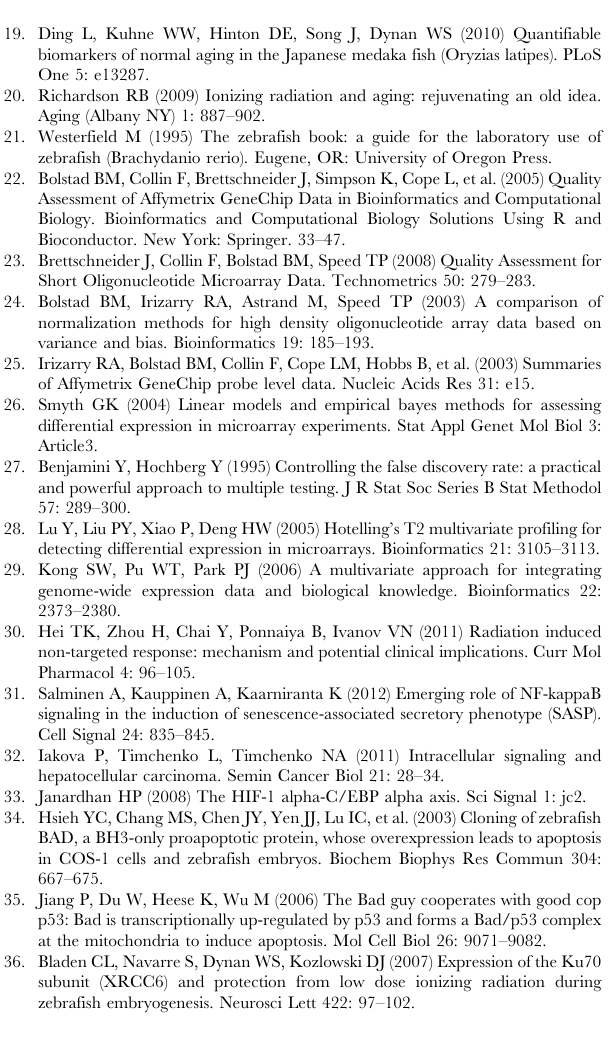
Table S5 Figure 5 gene list. List of genes that appear in the heat map in Figure 5. Column labels are the same as for Table S4. Note that gene name for badb has been corrected to ‘‘BCL2- agonist of cell death’’ as explained in the legend for Figure 5 in the main